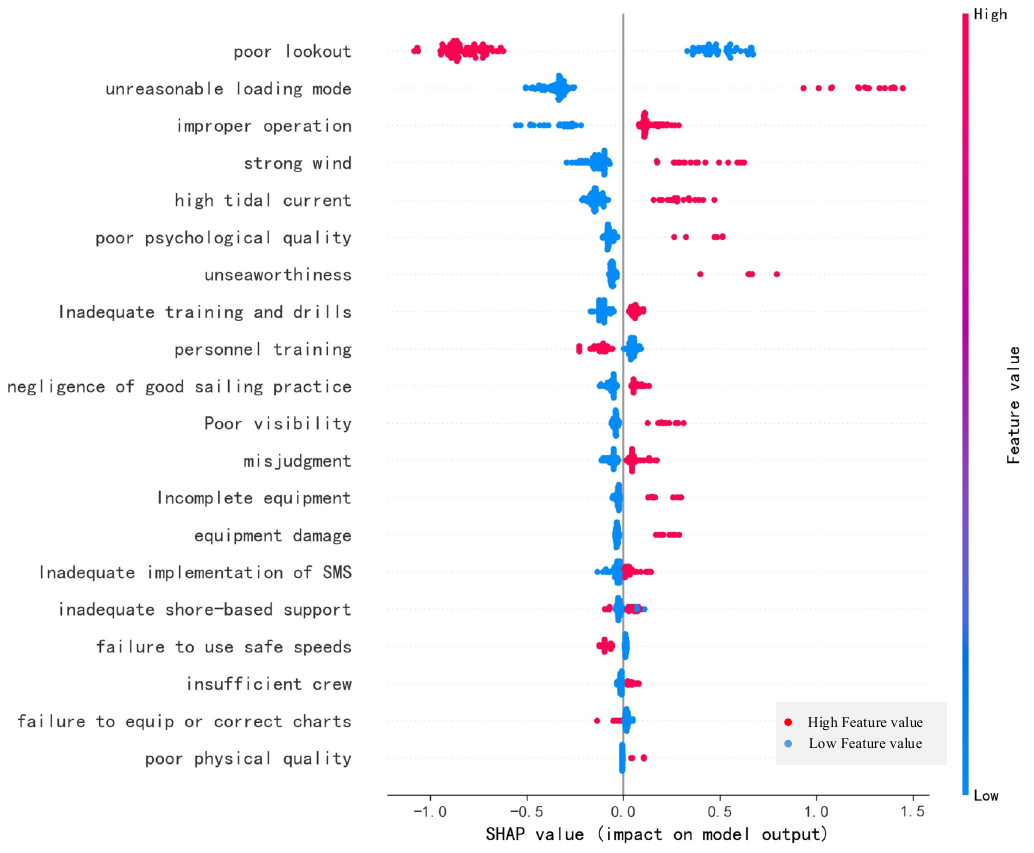
Figure 12. Scatter diagram of the comprehensive influence of the factors on capsizing